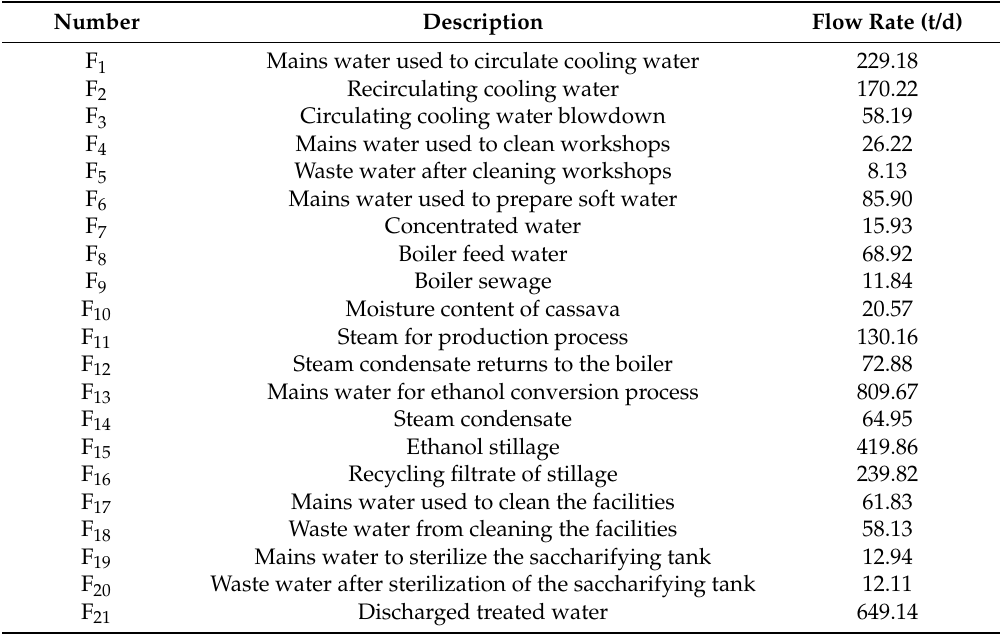
Figure 1. Flow chart of the water-using units at the bioethanol production plant. --- : Ethanol production zone; : Water loss by evaporation and drift. Table 1. Description and flow rate of the water-using units of the bioethanol production